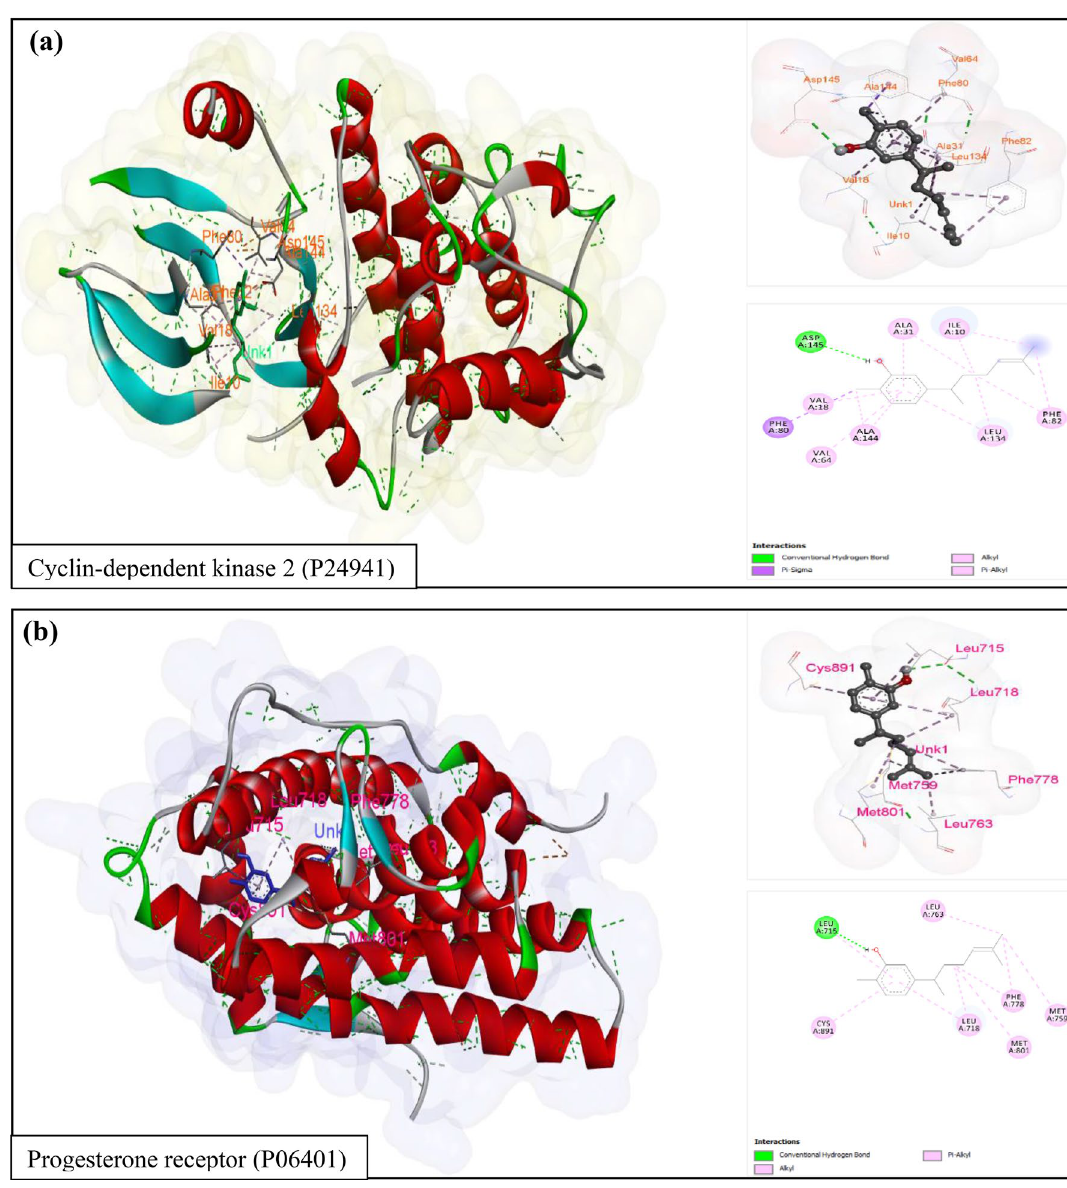
Figure 7. Docking results of XNT with ( a ) Cyclin-dependent kinase 2 (P24941), and ( b ) Progesterone receptor (P06401) selected proteins. Also showed their interacted amino acid residue types and